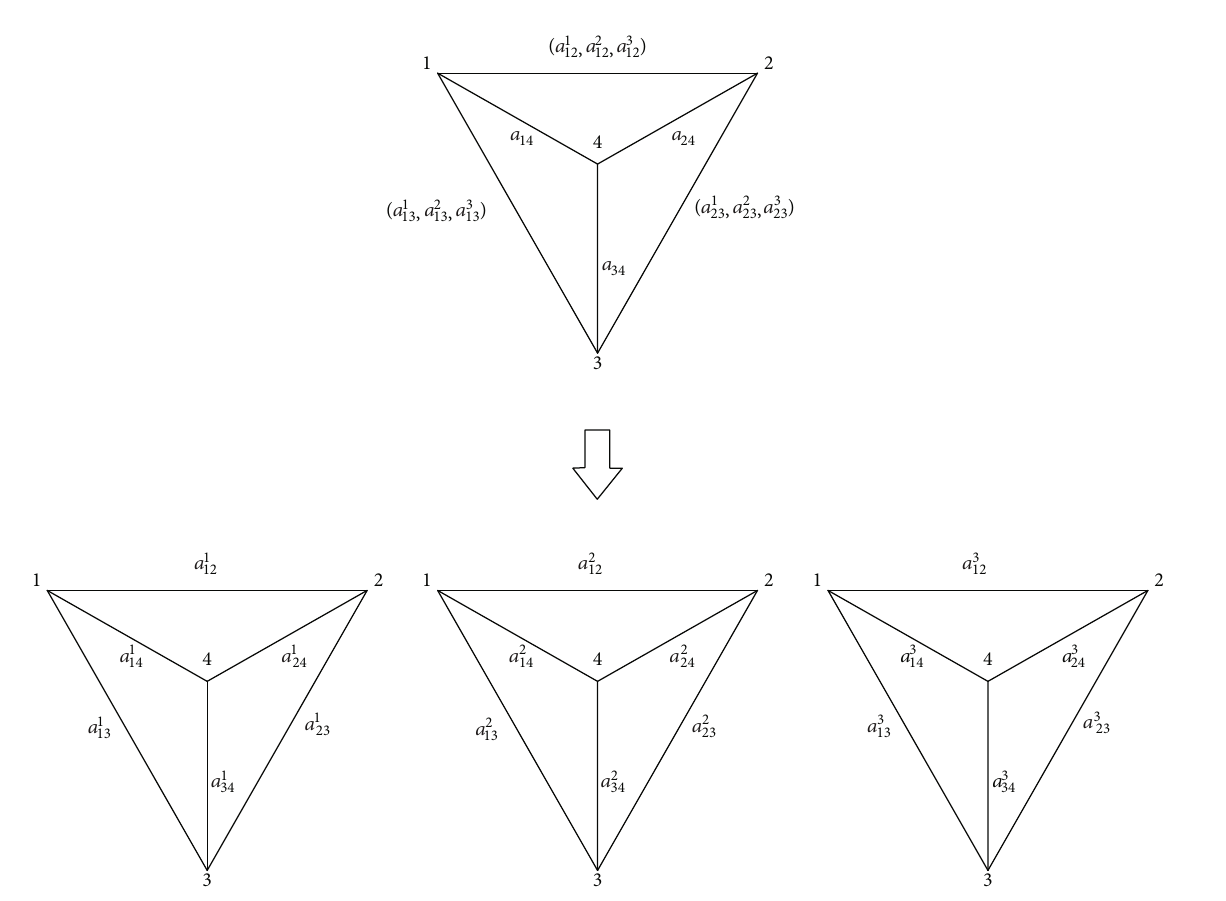
Figure 2: The topology map of complex network with triweights and its